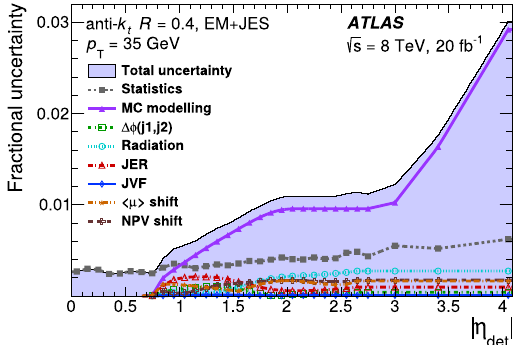
Fig. 19 Summary of uncertainties in the intercalibration as a function of the jet η det for anti- k t jets with R = 0 . 4 calibrated with the EM+JES scheme, separately for p T = 35 GeV (left) and p T = 300 GeV (right).